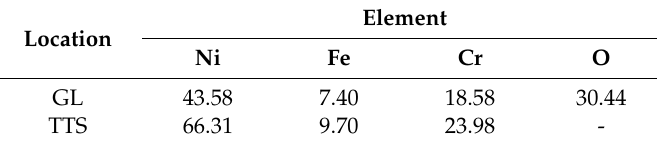
Figure 11. ( a ) An overview cross-sectional BFTEM image of the wear scar at the 6000th cycle after the final polishing of the FIB process. ( b ) The indexed SAED taken from the dashed circle in ( a ). ( c ) The corresponding DFTEM image taken from the red site in ( b ). ( d ) The magnified image from the rectangle in ( a ). ( e ) The indexed SAED taken from the dashed circle in ( d ). ( f ) The corresponding DFTEM image taken from the red site in ( e ). Table 3. Chemical composition of the GL and TTS taken from the EDS point analyses in Figure 10d